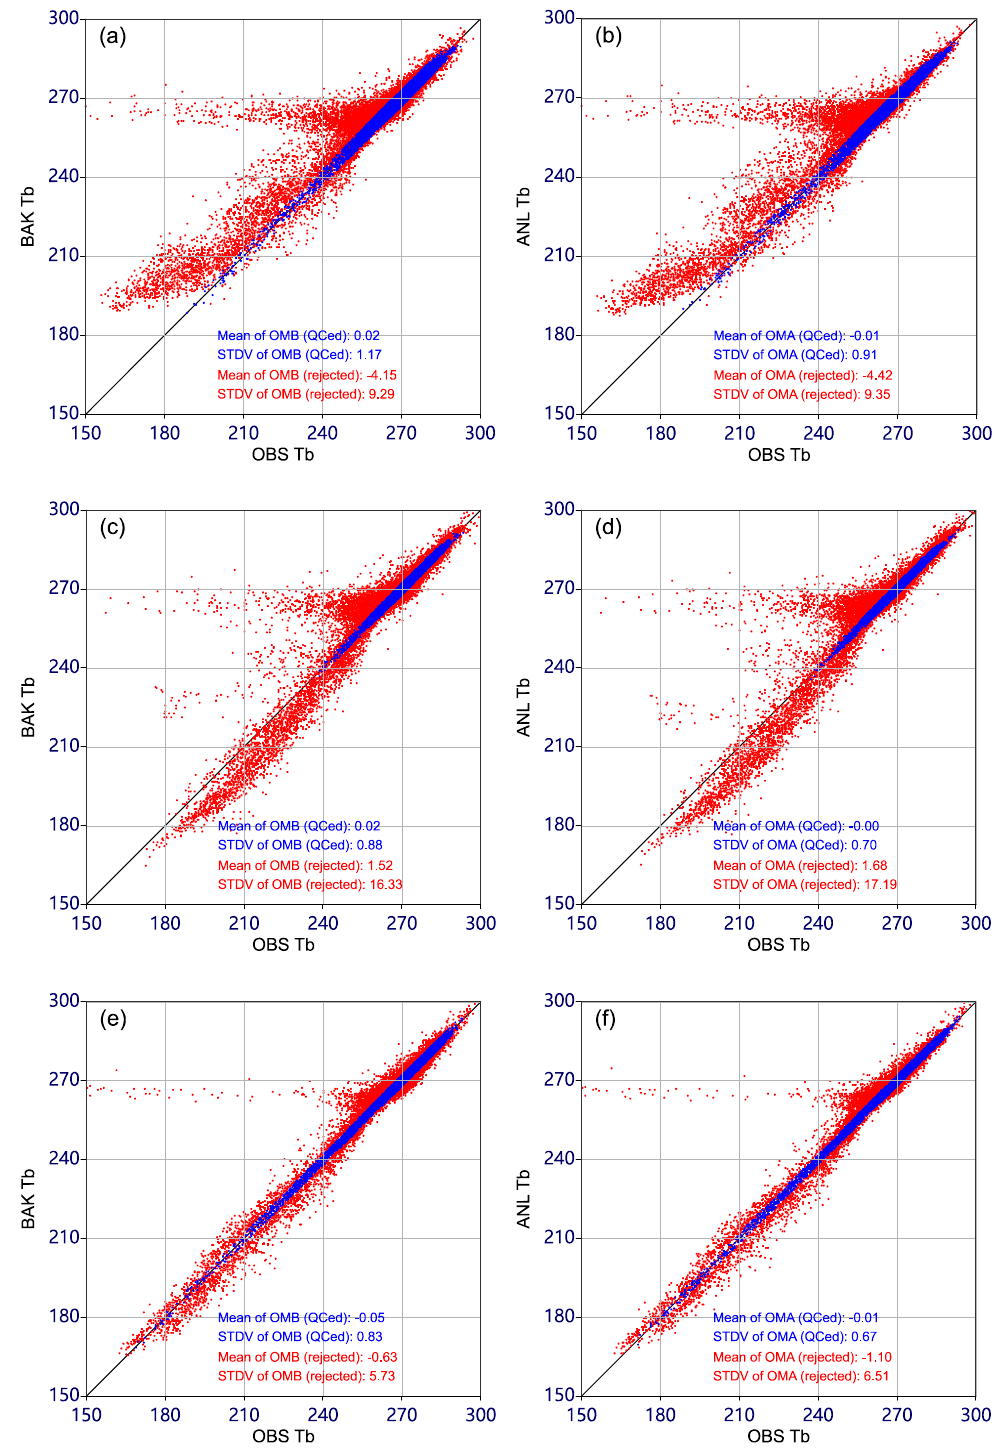
Figure 2. Scatterplots of observations from Feng ‐ Yun ‐ 3C (FY ‐ 3C) MWHS ‐ 2 channel 15 ( a , b ), Suomi National Polar ‐ orbiting Partnership (SNPP) ATMS channel 18 ( c , d ) and MetOP ‐ B MHS ( e , f ) passing (blue points) and rejected by (red points) quality control (QC) versus the equivalent brightness temperature calculated from 6 ‐ h forecast ( a , c , e ) and analysis ( b , d , f ) in the “MWHS ‐ 2” experiment. The time period of observations is from 21Z 31 July 2016 to 03Z 2 August 2016.